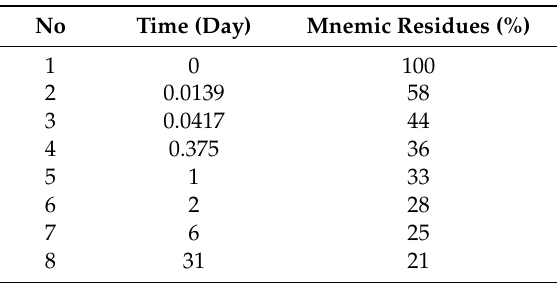
Table 1. Ebbinghaus forgetting experimental